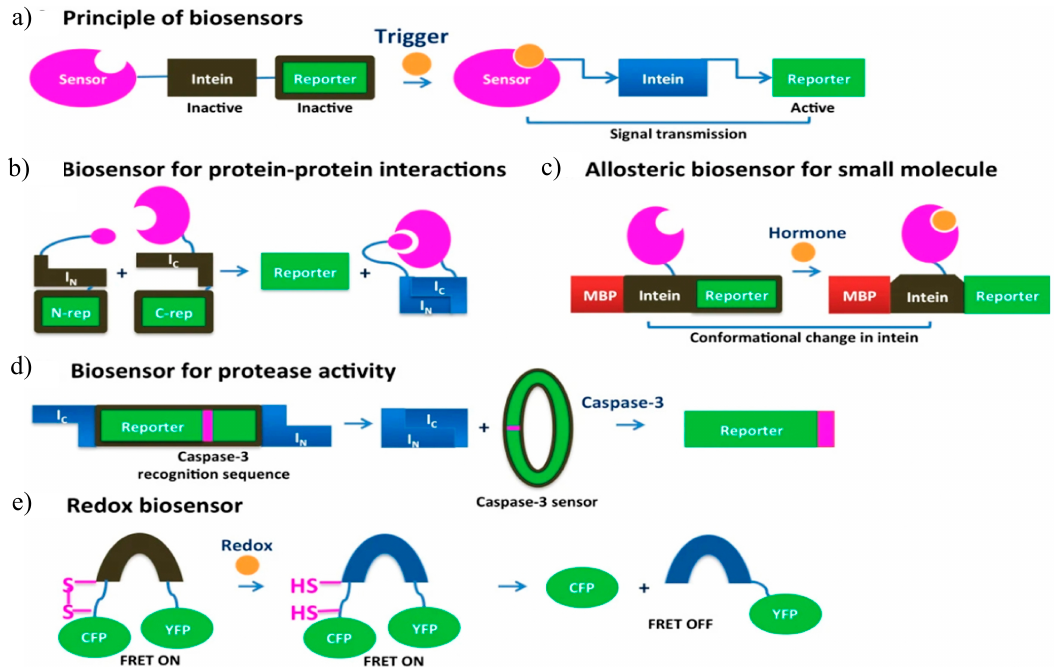
Figure 12. Schematic representation of intein-mediated biosensors. Segments either coloured brown or enclosed in a brown box indicate an inactive intein or reporter. ( a ) Overview of use of an intein as a biosensor. ( b ) Use of an intein-based system to sense protein–protein interactions. ( c ) Intein-mediated allosteric biosensor for small molecules. ( d ) Intein-mediated biosensor for protease activity. ( e ) Intein-mediated redox biosensor. CFP and YFP are cyan and yellow fluorescent proteins, respectively [9].